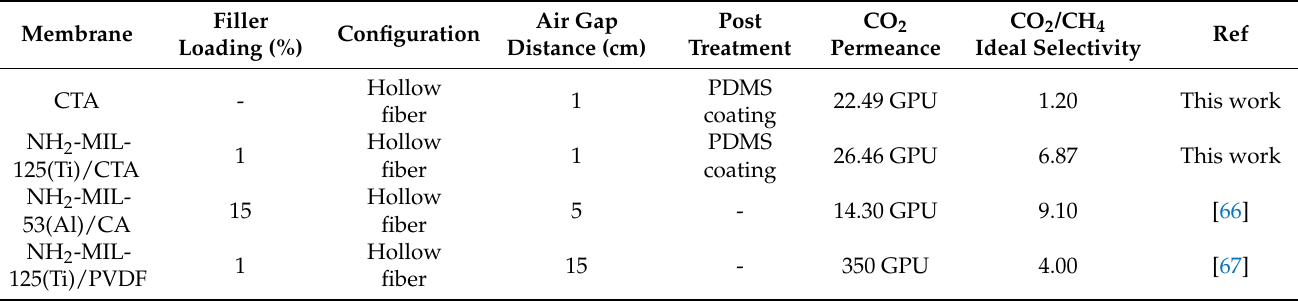
Table 2. Comparison of CO 2 /CH 4 gas permeability results of CTA HFM and NH 2 -MIL-125(Ti)/CTA HFMMM in the current work with those results reported in the